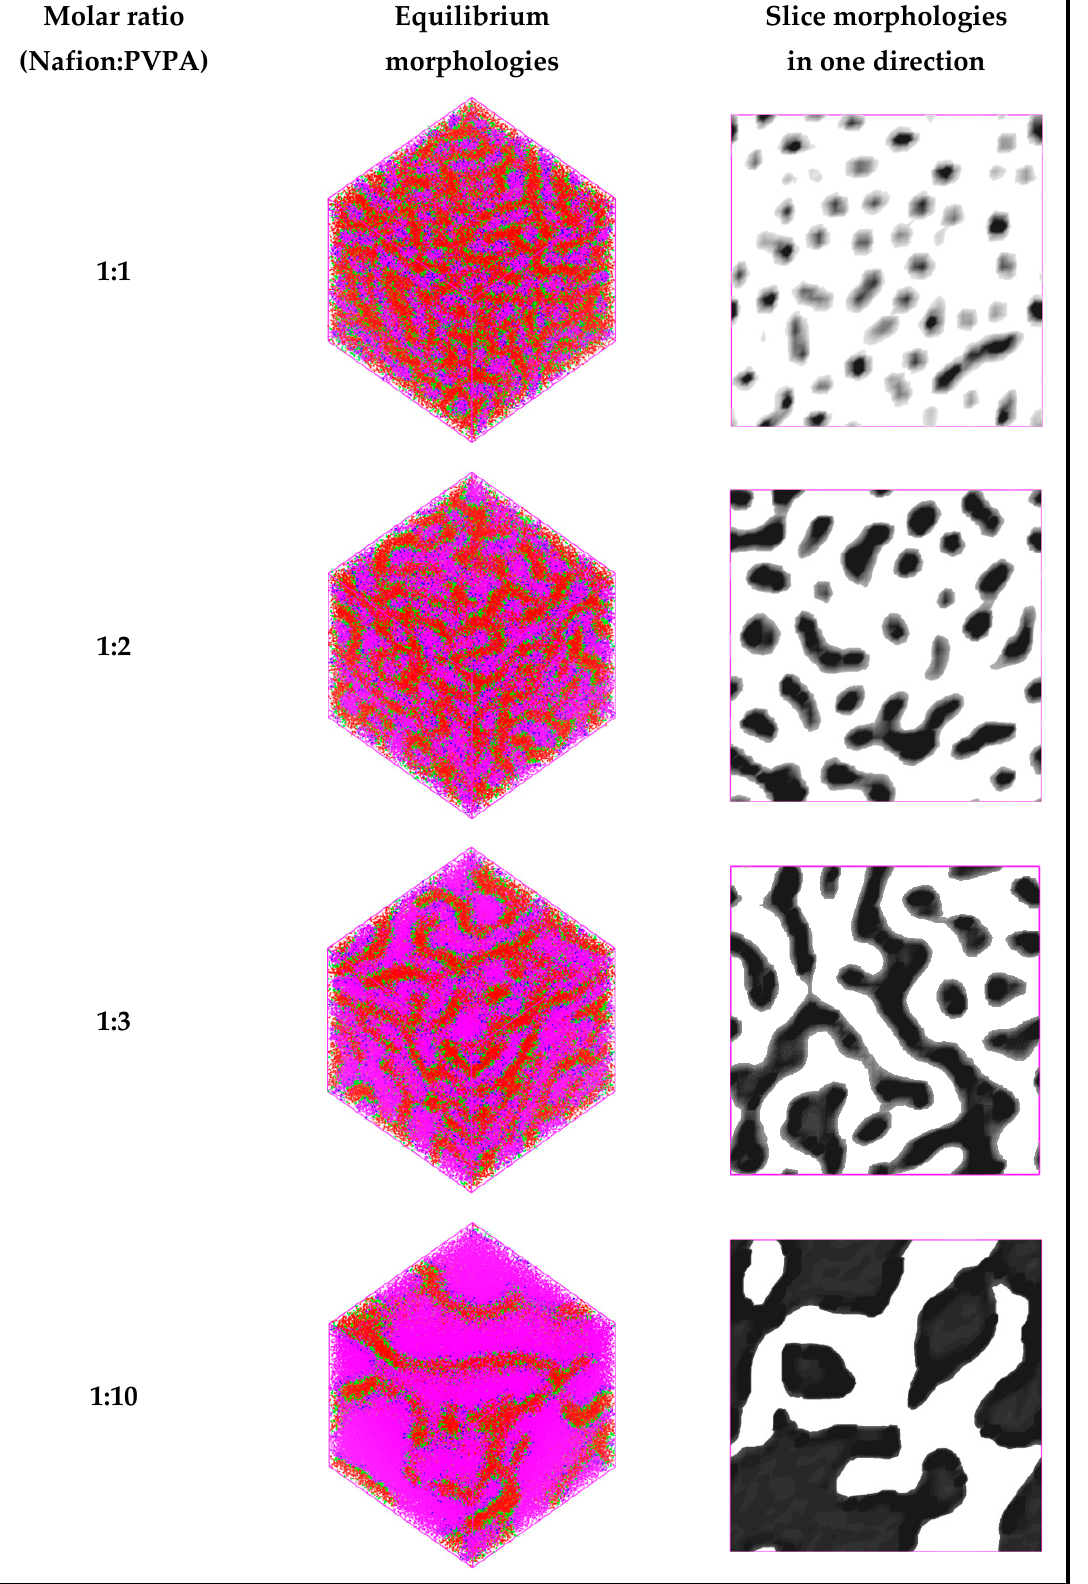
Figure 2. Comparison of equilibrium morphologies and slice morphologies of Nafion/PVPA blend membranes with various molar compositions.